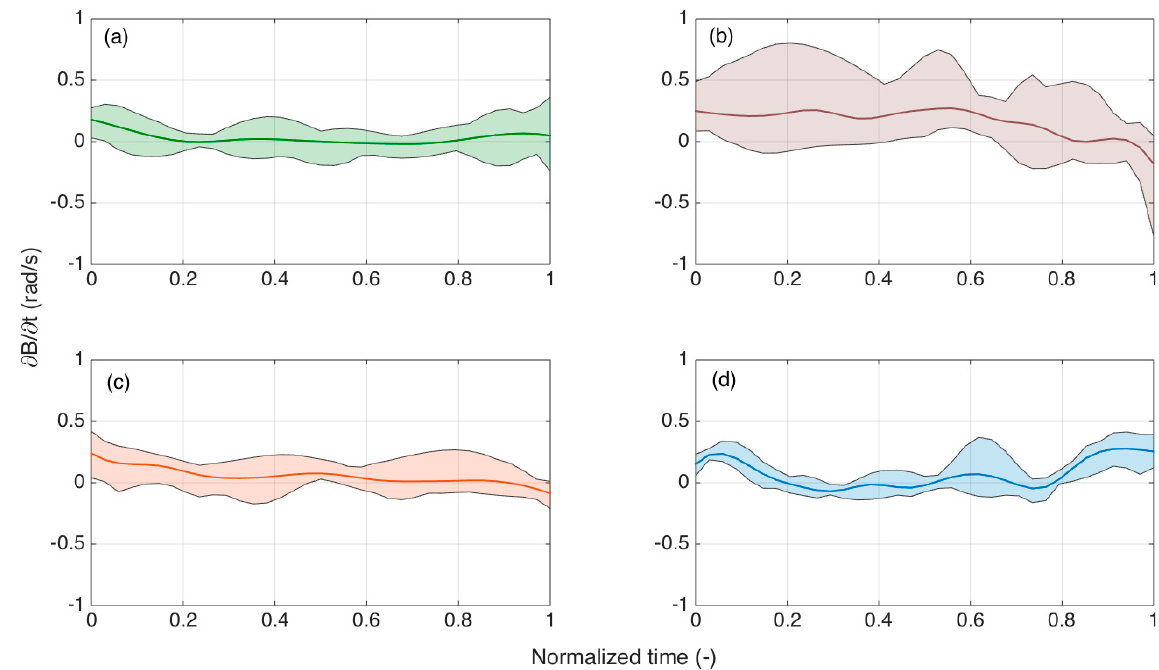
Figure 12. Analysis of the time derivative of SPBA over normalized time for each class of experiments. The charts show ∂ B / ∂ t patterns, solid lines = mean for all experiments, shaded regions = minima/maxima at each normalized time. ( a ) Straight insertion; ( b ) large curvature; ( c ) Reduced bending; ( d ) failed insertions.